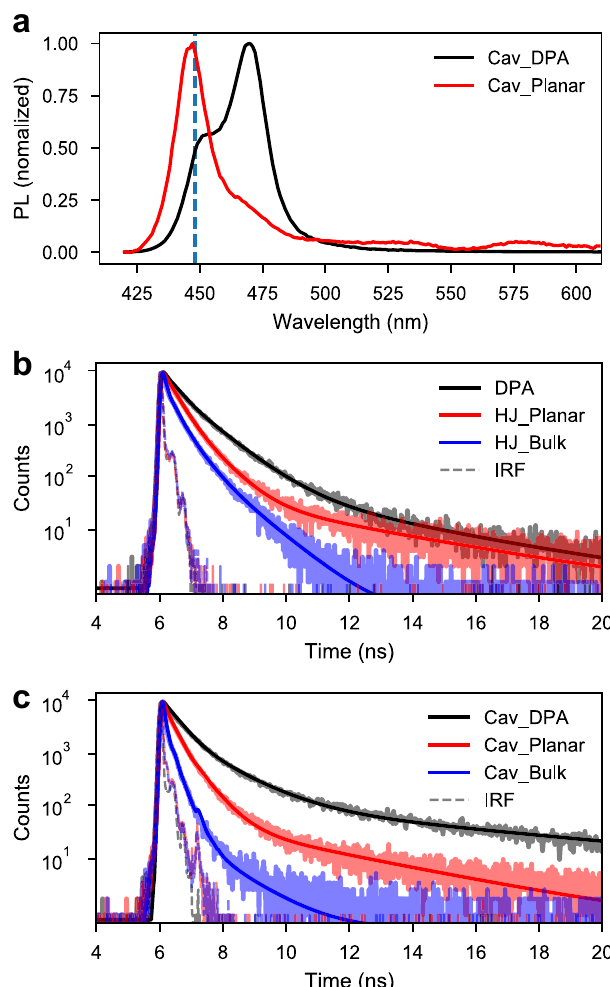
Fig. 5 Steady-state and time-resolved emission from HJ fi lms and cavities. a Steady-state emission from Cav_DPA (Ag/10 nm mCP/163 nm DPA/~80-nm PVA/Ag) and Cav_Planar HJs (Ag/10-nm mCP/163-nm DPA/40-nm PTCDA/15-nm TmPyPB/Ag) probed at normal angle. The wavelength of the excitation light was 405 nm, where only DPA absorbs. The vertical blue line (at 448 nm) indicates the emission from uncoupled DPA molecules. Time-resolved PL decay of fi lms ( b ) and cavities ( c ) probed at the emission position of DPA (448 nm), together with fi ttings to a three- exponential model (solid line). The excitation wavelength was 405 nm. The black curves represent decays from DPA fi lms, red curves represent planar HJs, and blue curves represent bulk HJs (10 nm mCP/163 nm DPA + 40 nm PTCDA/15 nm